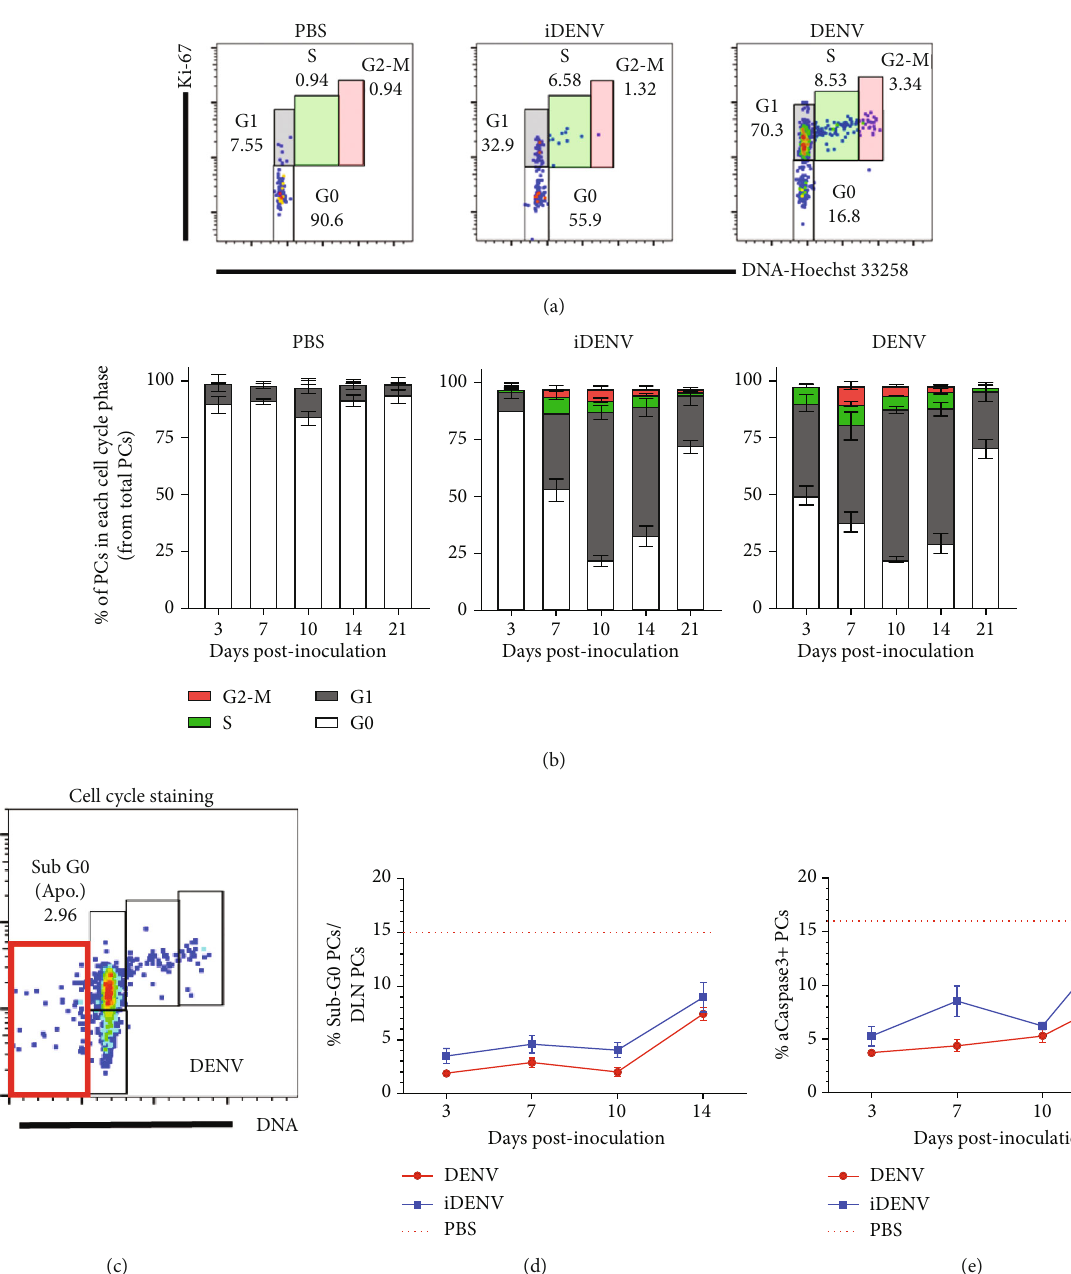
Figure 5: DENV cutaneous infection induces a rapid entrance of PCs to cell cycle and a low apoptosis ratio. For cell cycle analysis by fl ow cytometry, cell suspensions from DLNs were colabelled with antibodies to surface CD138 and Ly6C and intranuclearly for Ki-67. The DNA was stained with Hoechst 33258. (a) Representative cell cycle gating analysis on PCs from DLN of mice 7 d p.i. with DENV or controls. (b) Percentage of PCs in each cell cycle phase during the kinetic in the DLN of mice postcutaneous inoculation with DENV, iDENV, or endotoxin-free PBS. (c) Representative cell cycle gating strategy on PCs (CD138 + Ly6C + ) from a DLN of mice cutaneously inoculated with DENV emphasizing the sub-G0/apoptotic population (red box). (d) Proportion of sub-G0/apoptotic PCs during the kinetic. (e) Proportion of apoptotic PCs expressing the active form of caspase-3 during the kinetic. Red dotted lines in (d) and (e) represent the mean levels in the PBS group. Data shown represent the mean ± SEM and are representative of four independent experiments with two mice per group per time